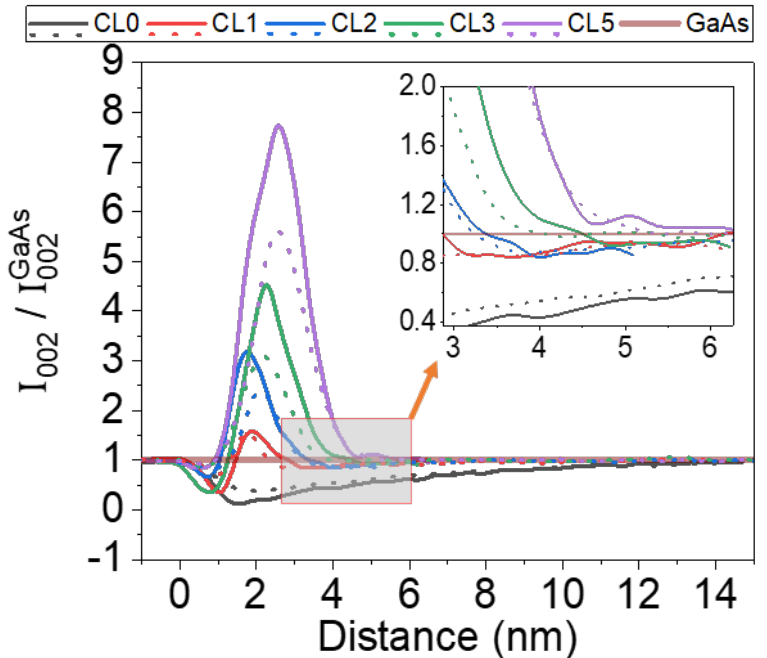
Figure 7. Normalized profiles of the intensities in g002 DF images of WL/CL region along the growth direction simulated using the compositional profiles of Figure 6 (solid line) and experimental g002 DF images (dot line) for the different AlAs/InAs/GaAs QD layers. The inset shows the presence of a second darker streak after the brighter AlAs contrast due to In surface segregation.